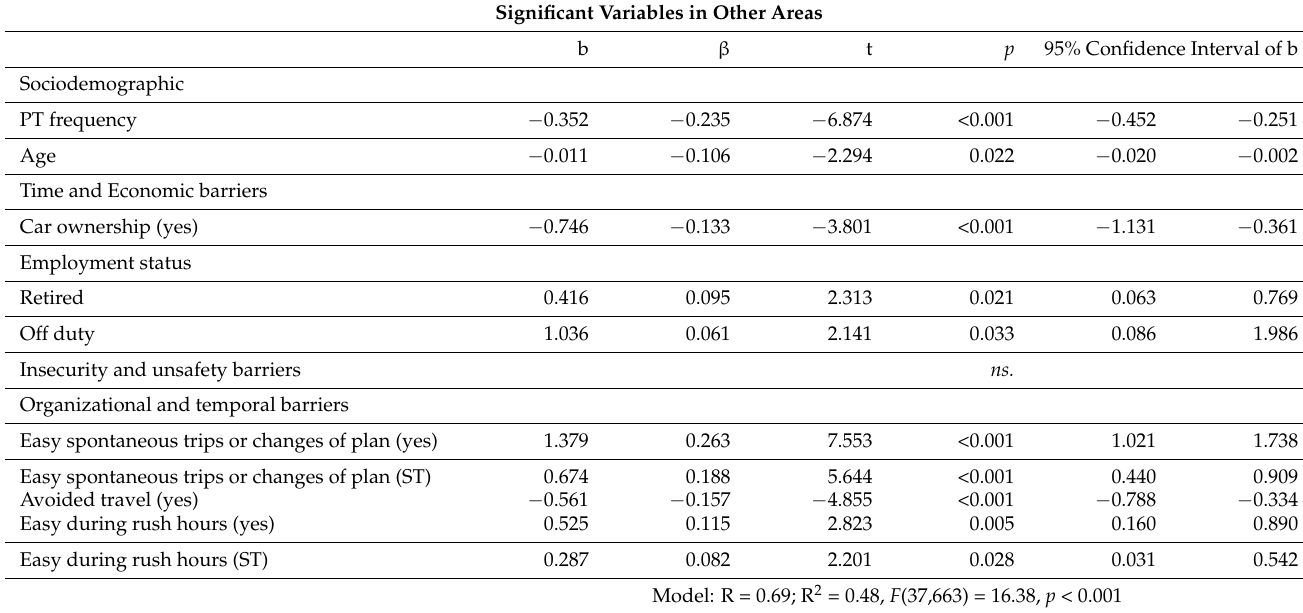
Table 3. Significant variables in the regression analysis of perceived accessibility of public transport in other areas ( N =